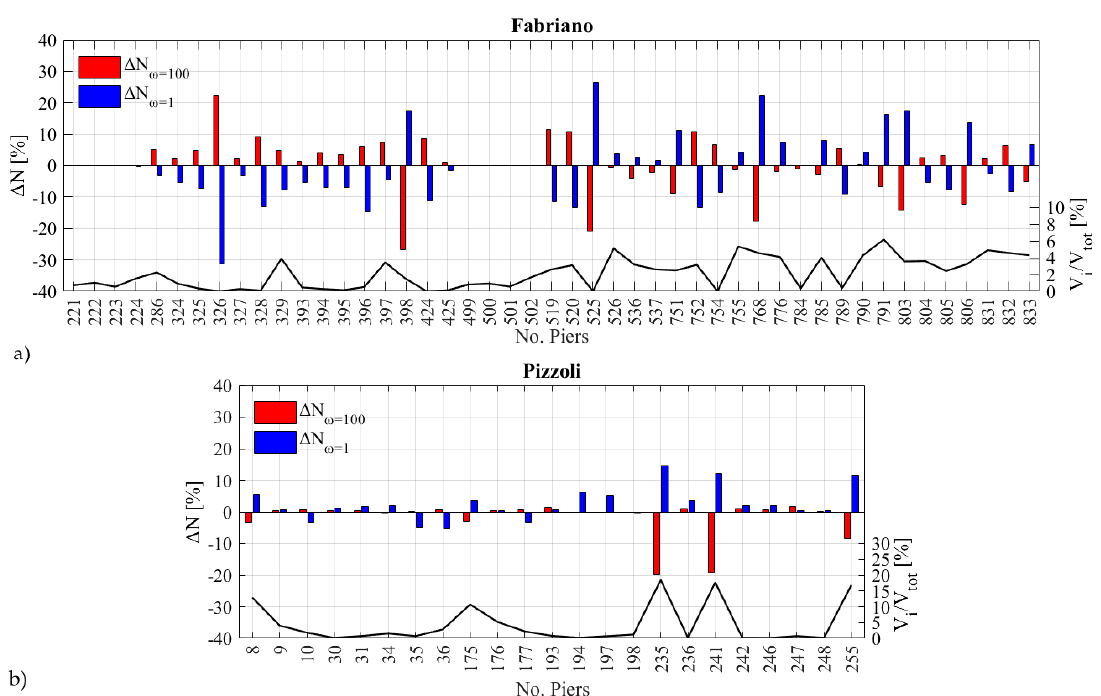
Figure 25. Variation on the axial force acting on piers after the application of vertical loads (on the top, left axis) and rate of horizontal forces equilibrated by each pier respect to the maximum base shear of the overall pushover curve (on the bottom, right axis). Results refer to the former Fabriano courthouse ( a ) and the Pizzoli’s town hall ( b ).